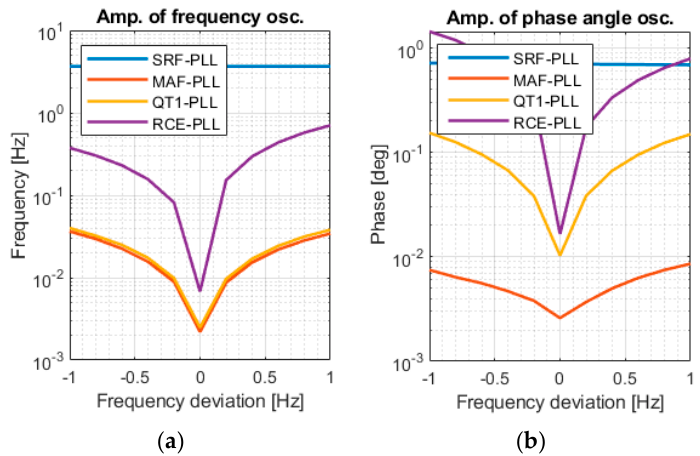
Figure 16. Effect of fundamental frequency deviation on the amplitude of undamped oscillations during voltage harmonics. ( a ) Frequency; ( b ) phase angle.